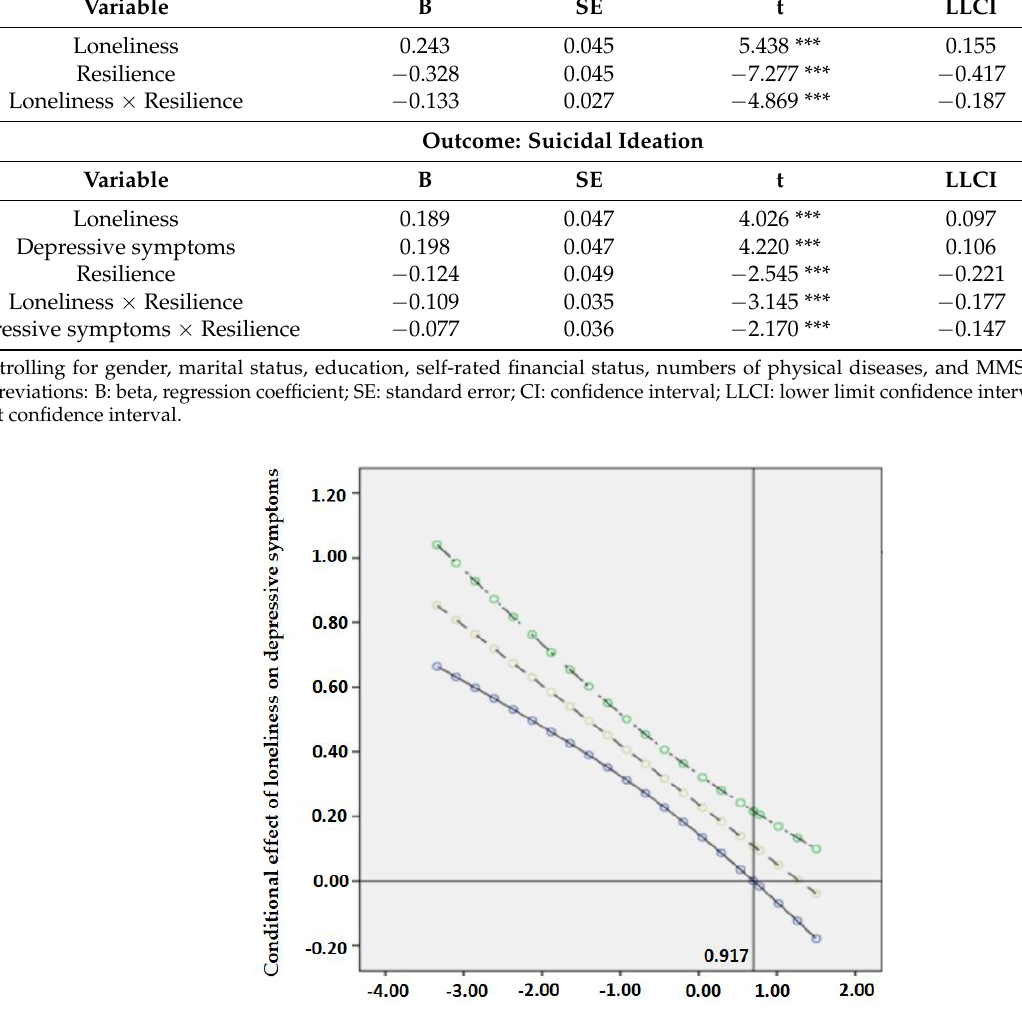
Figure 3. A plot of the effect of loneliness on SI at values of resilience.